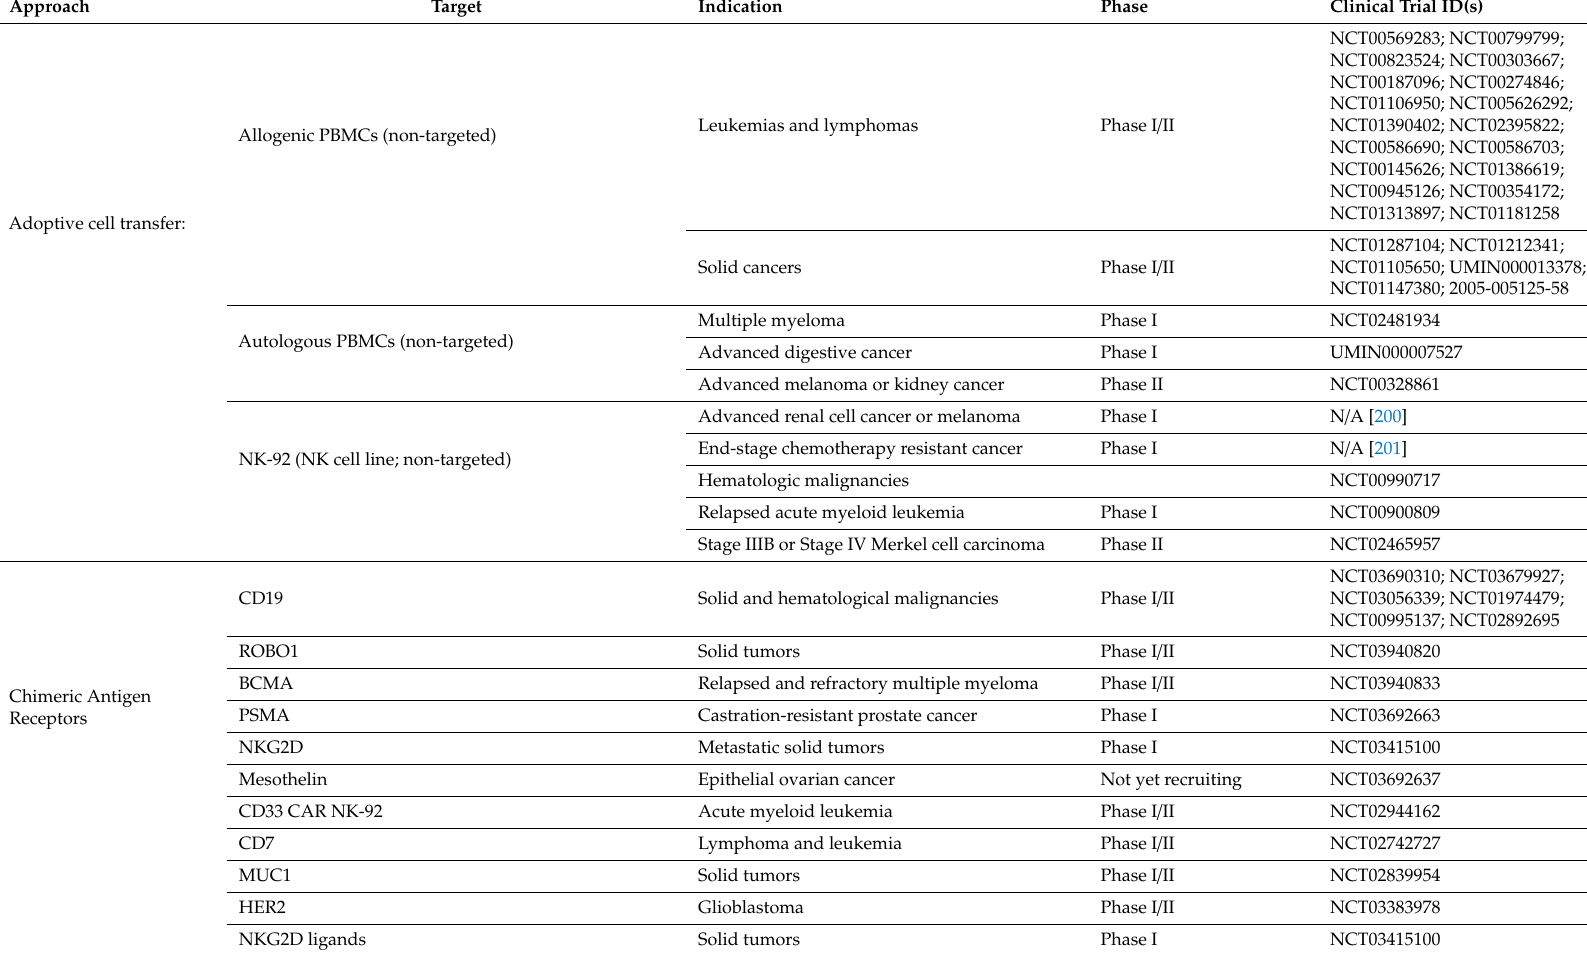
Table 1. Completed and currently active clinical trials of NK cell-based